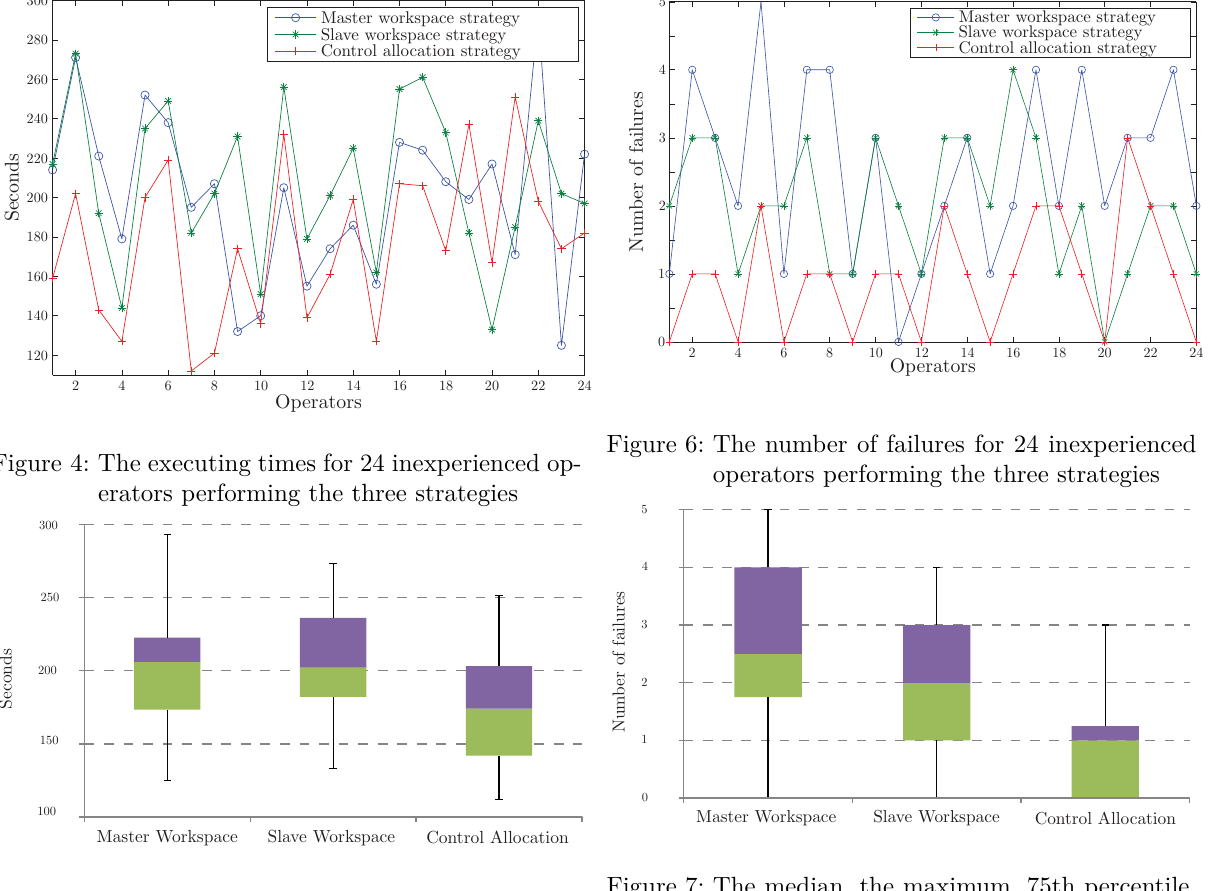
Figure 5: The median, the maximum, 75th percentile, 25th percentile and minimum values of exe- cuting times.